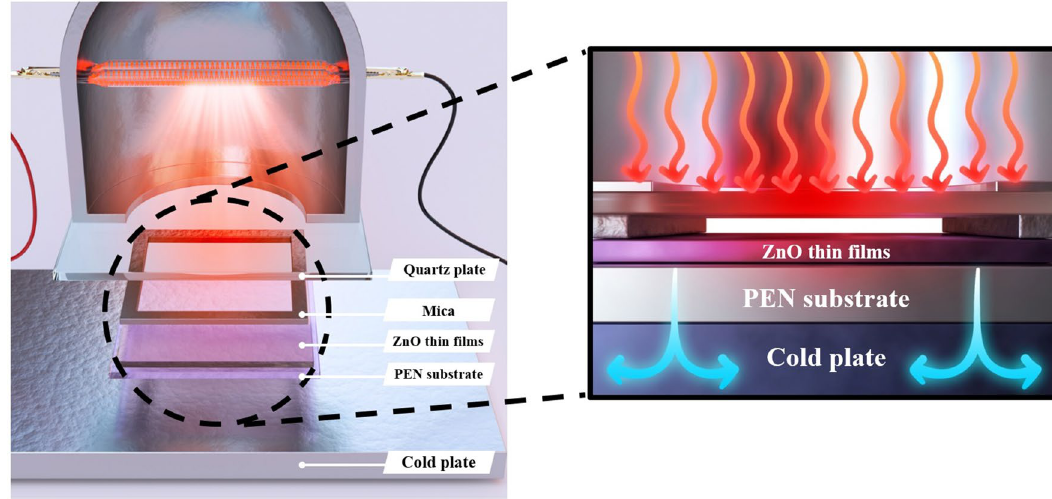
Figure 1. Schematics images of the thermal dissipation annealing (TDA) systems for annealing ZnO thin films deposited onto PEN substrate (figures not drawn to scale). The schematic images were prepared by first author Dongwan